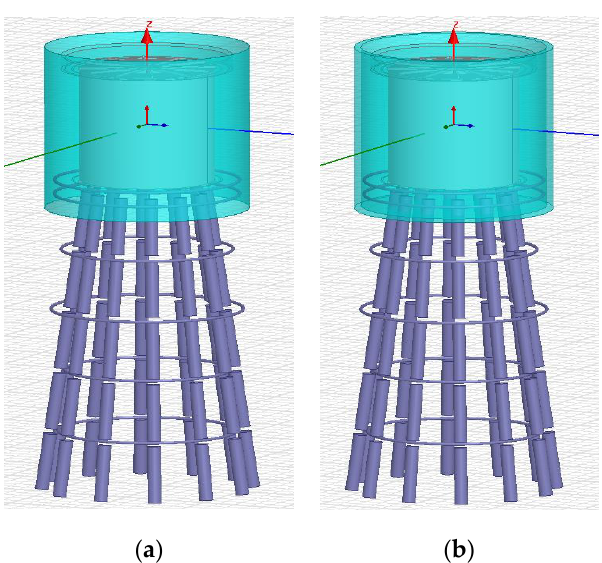
Figure 12. Shield at different positions. ( a ) single-layer hollow cylindrical shield; ( b ) double-layer hollow cylindrical shield.